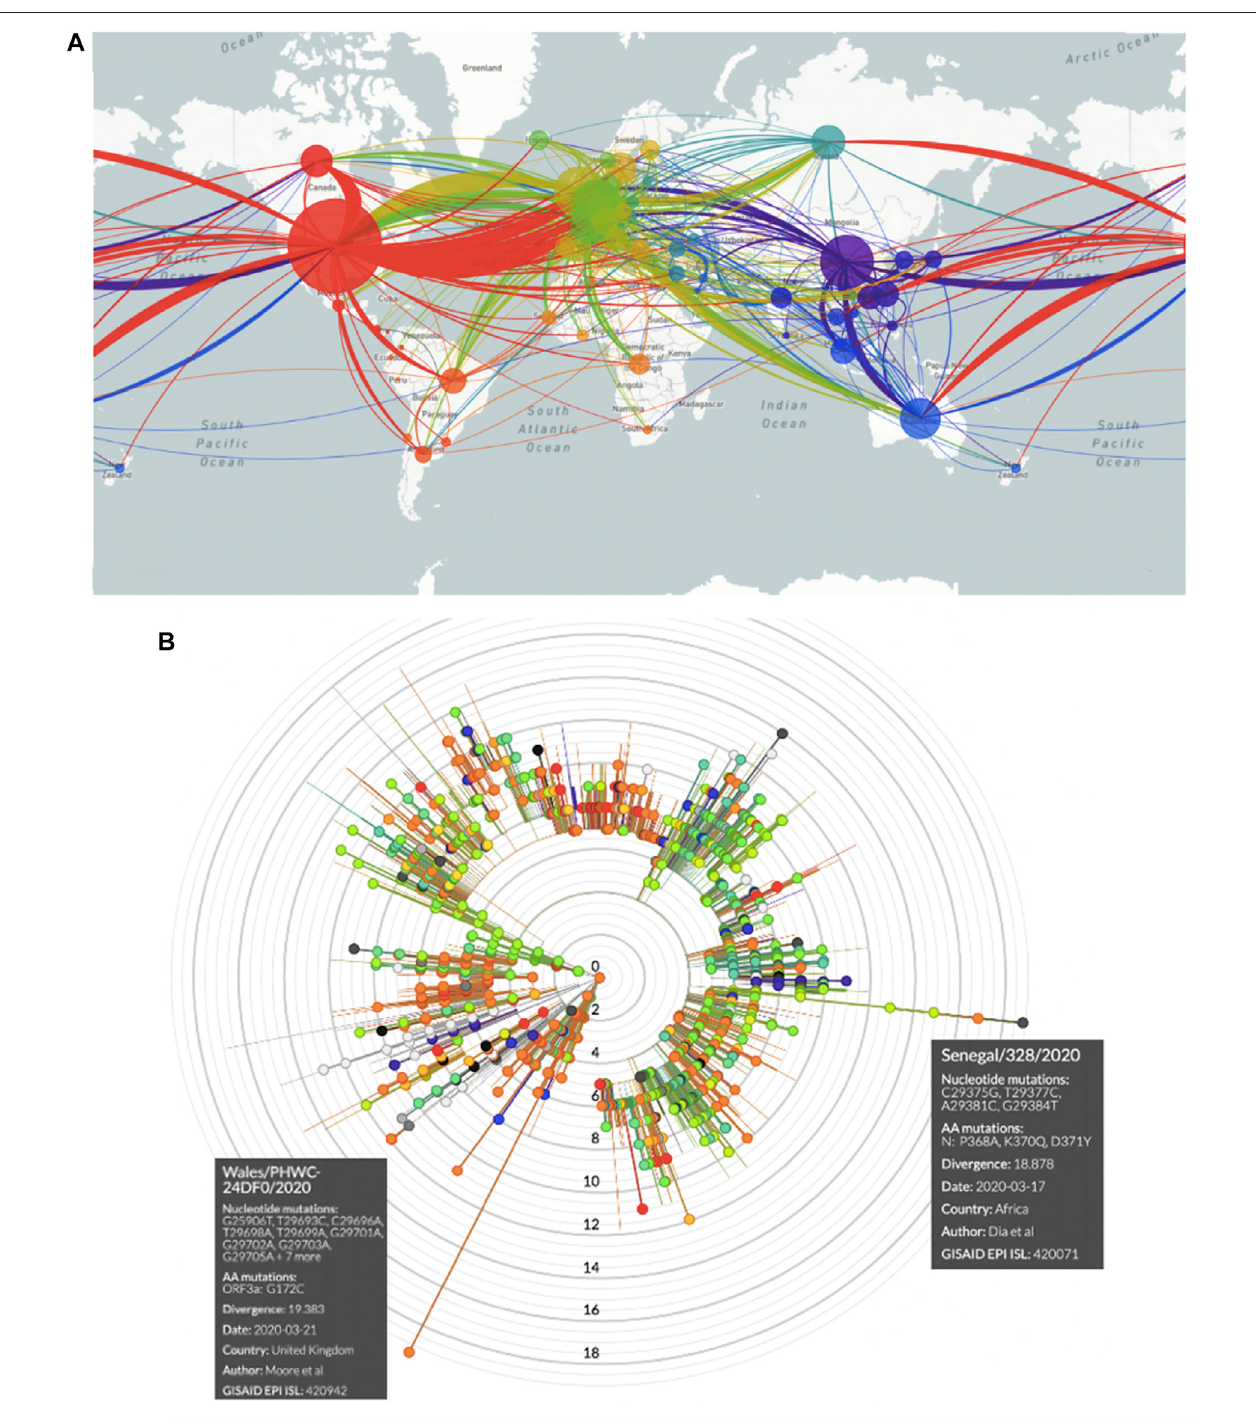
FIGURE 2 | COVID-19 spreading and SARS-CoV-2 mutations. (A) Worldwide SARS-CoV-2 diffusion trajectories. Circle diameters are proportional to the number of virus isolates showing different sequences/acquired mutations. (B) Radial diagram of SARS-CoV-2 mutations worldwide. Concentric circles indicate the number of acquired genomic mutations detected in individual virus isolates. Each color identi fi es the geographical origin of the virus isolates.